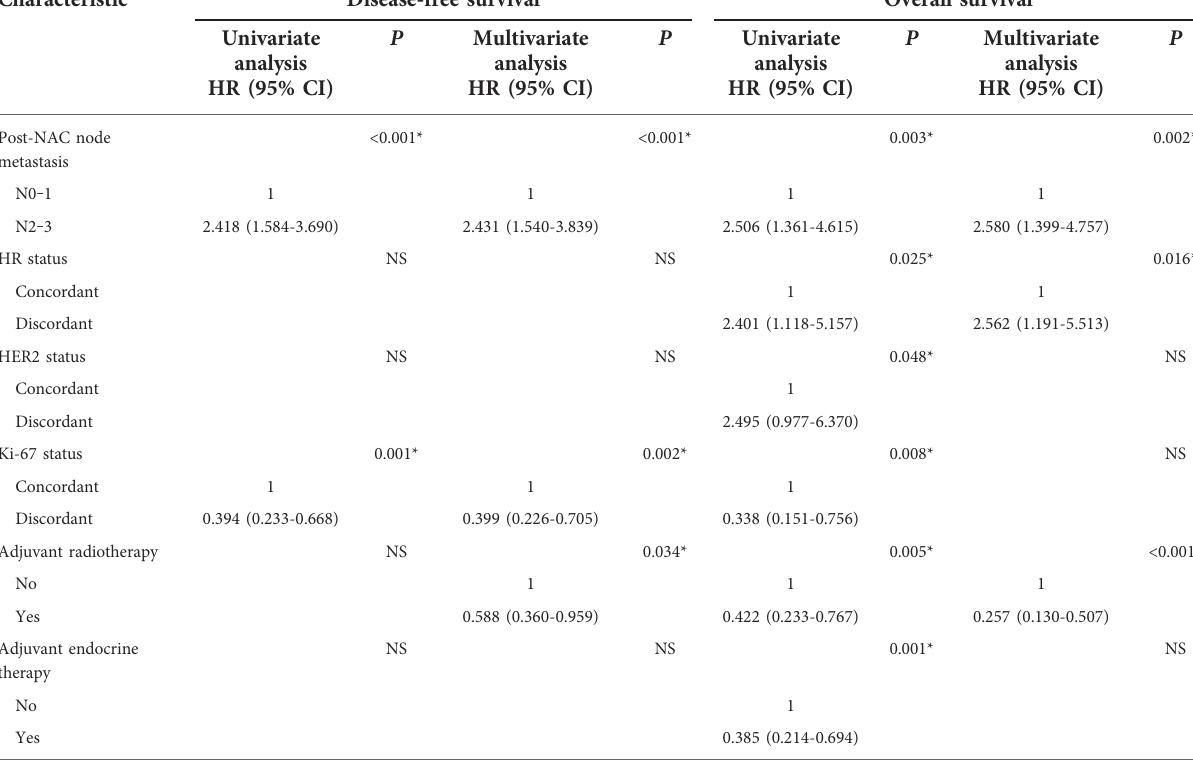
CI, con fi dence interval; DFS, disease-free survival; HER2, human epidermal growth factor receptor 2; HR, hazard ratio; HR, hormone receptor; NAC, neoadjuvant chemotherapy; NS, not signi fi cant; OS, overall survival. * P <0.05.